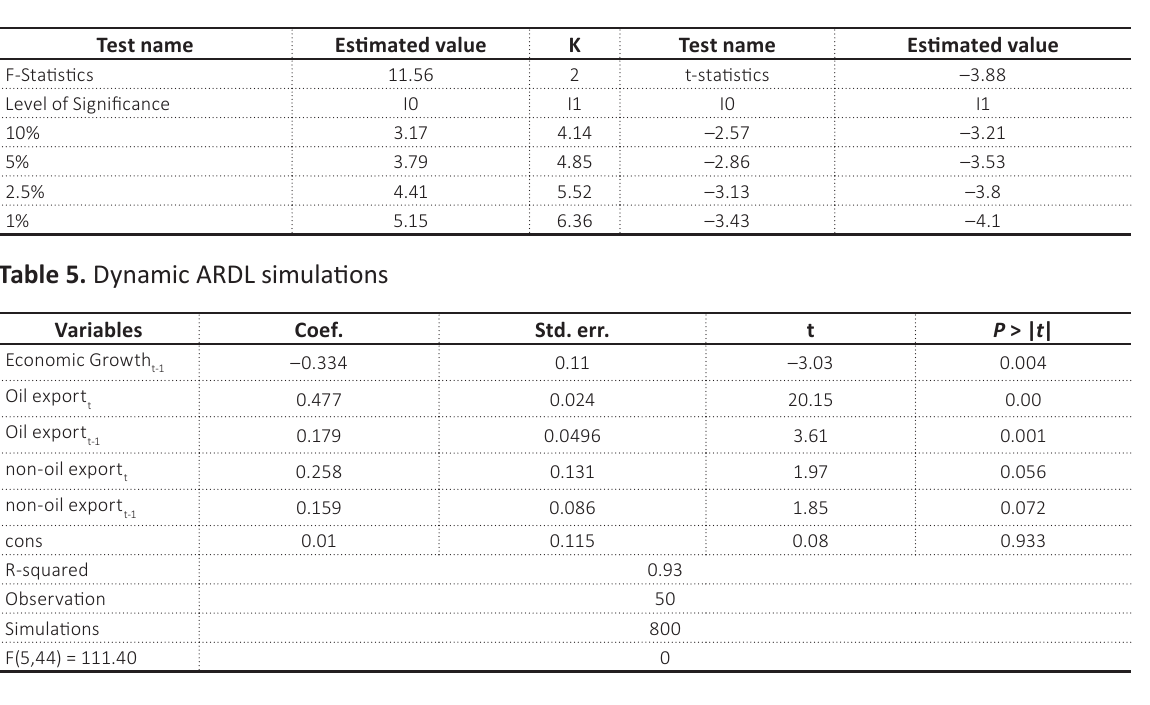
Table 4. Bound test for ARDL